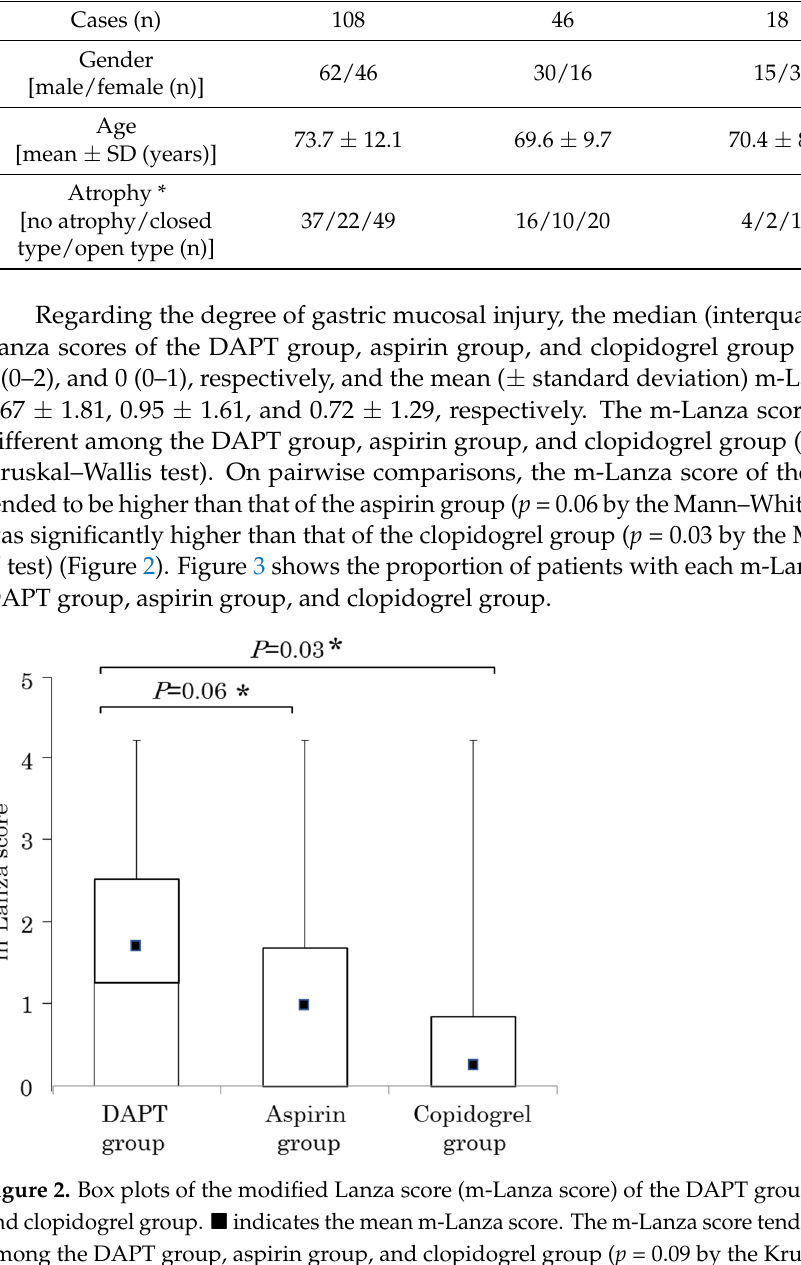
Figure 3. The proportions of patients with each modified Lanza score (m-Lanza score) in the DAPT group, aspirin group, and clopidogrel group. DAPT, dual antiplatelet therapy consisting of low- dose aspirin and clopidogrel. Of the 172 patients, 30 had severe gastric mucosal injury. Of the 30 patients with se- vere gastric mucosal injury, 16 patients had no atrophy and closed-type atrophy (16/30, 53.3%). On the other hand, 113 of the 172 patients had no gastric mucosal injury; of the 113 patients with no gastric mucosal injury, 58 patients had no atrophy and closed-type atrophy (58/113, 51.3%). There was no significant difference in the degree of atrophy be- tween those with severe gastric mucosal injury and those who did not have gastric muco- sal injury.